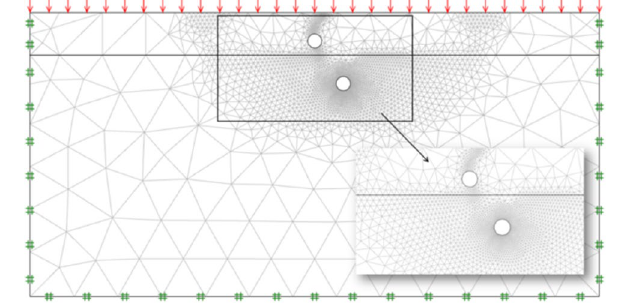
Figure 2. General view of numerical